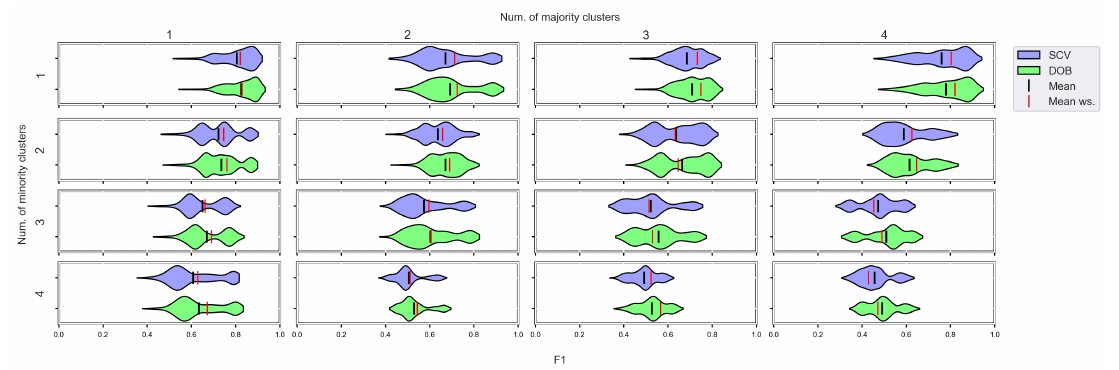
Figure 7. F 1 values concerning the number of clusters in the minority and majority classes in the case of the DTree classifier. (IR8).